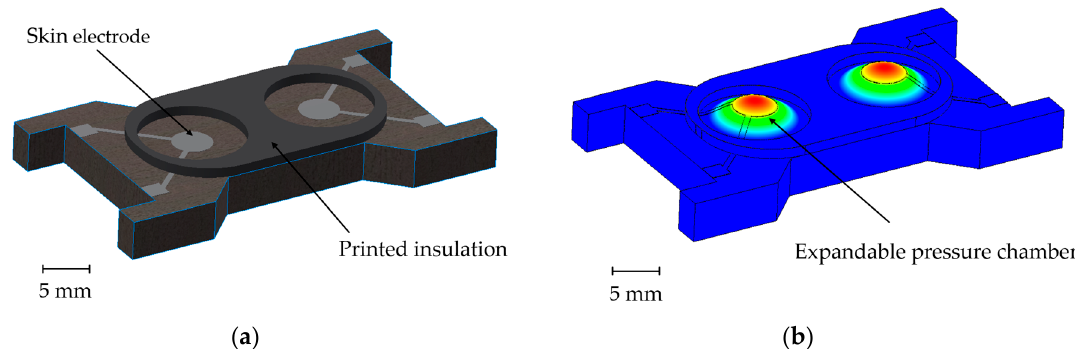
Figure 1. ( a ) Schematic drawing of the electrode module; ( b ) Working principle of the electrode module.